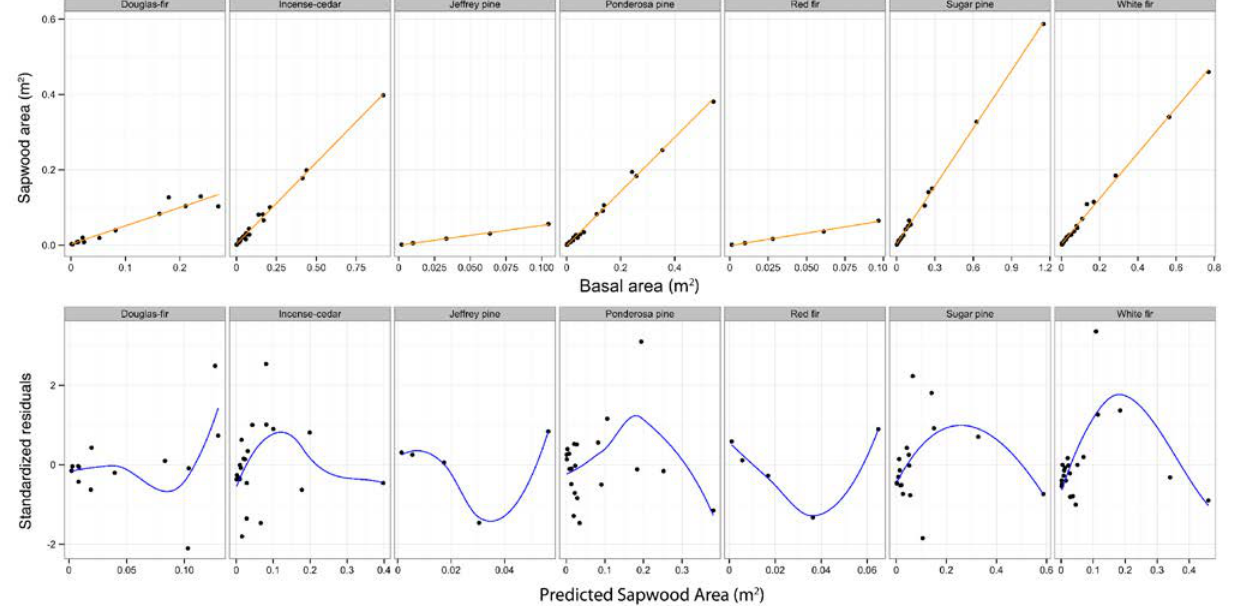
Figure 4. Linear regressions of cross sectional sapwood area (m 2 ) at breast height against basal area are shown in the top row for each species. Standardized residuals from the linear regressions are plotted against predicted sapwood area (m 2 ) in the bottom row. LOESS regressions of the standardized residuals against predicted sapwood area are also shown in the bottom